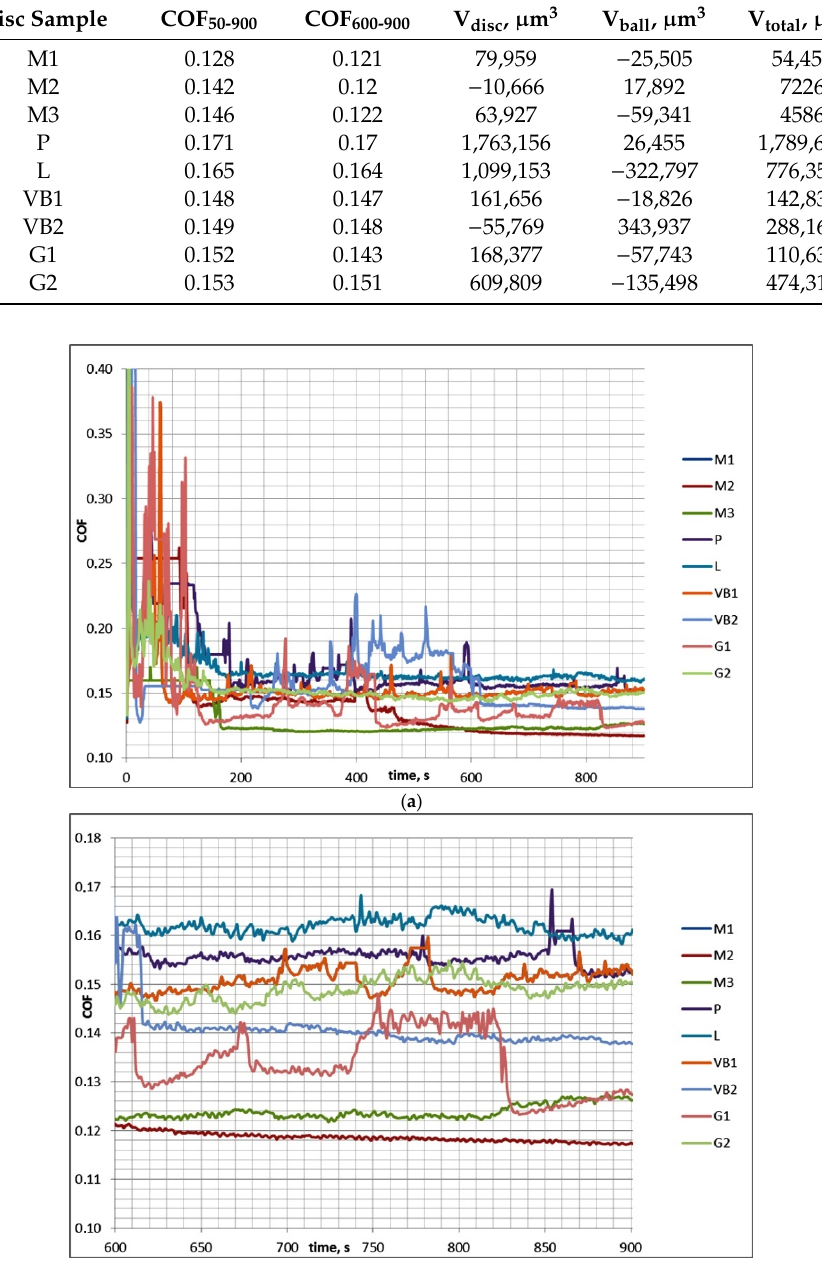
Table 3. Results of test A (f = 80 Hz, P = 45 N, temperature 30 ◦ C, the number of cycles 72,000).